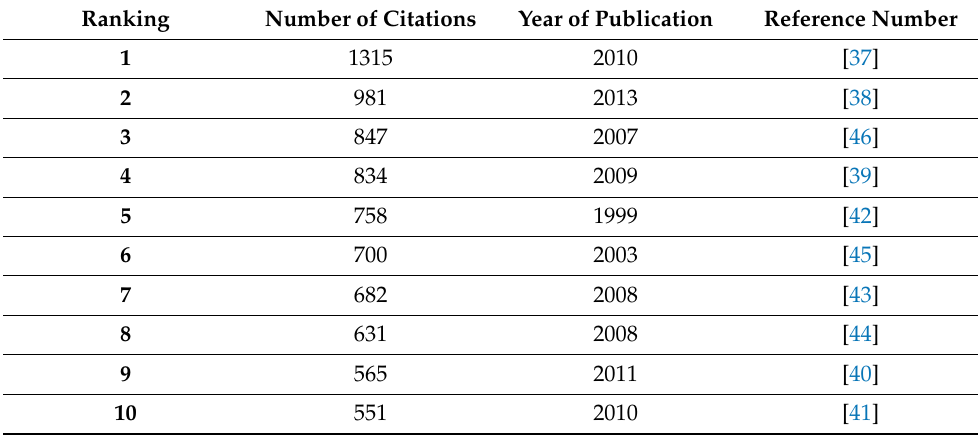
Table 2. Frequently cited research on HVs and PHVs in Engineering, Electrical, and Electronics